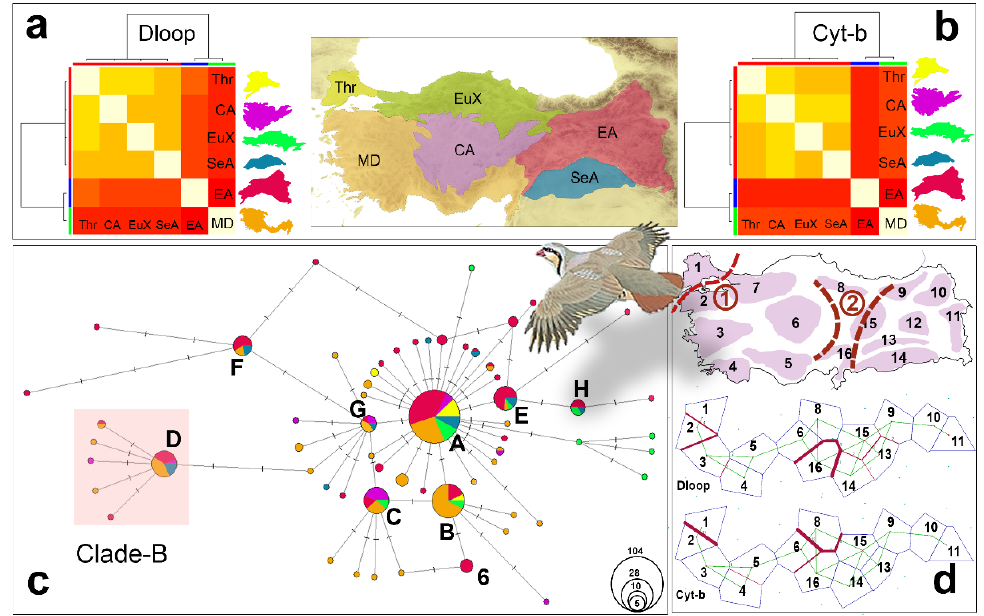
Figure 2. Geographic genetic structure of haplotypes. Results of heatmap analyses: ( a ) Dloop and ( b ) Cty-b. The map of six geographic regions in Türkiye: Thr: Thrace, MD: Mediterranean, EuX: euxinic, Ca: Central Anatolia, EA: East Anatolia, SeA: Southeast Anatolia. ( c ) Cty-b haplotype network. ( d ) Barrier analyses. The dashed lines marked as 1 and 2 represent the Marmara waterway (1) and the Anatolian Diagonal (2).